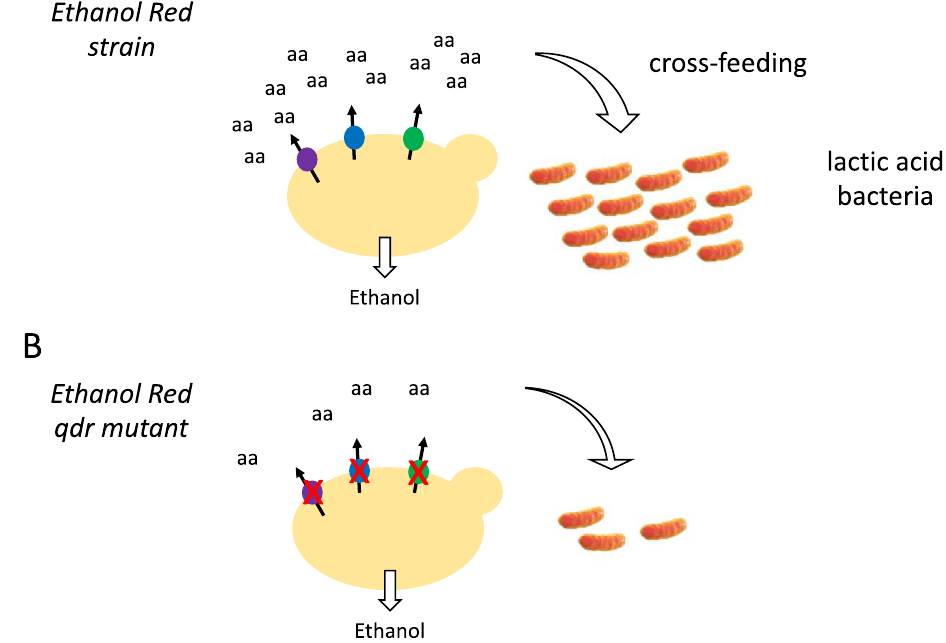
Figure 4. A novel strategy for reducing the risk of bacterial contaminations during bioethanol production. ( A ) The Ethanol strain used in this study excretes multiple amino acids via Qdr amino-acid exporters of the DHA1 family, thereby promoting proliferation of contaminating lactic acid bacteria. ( B ) Loss of Qdr transporters by means of homozygous mutations reduces amino acid excretion and cross-feeding of lactic acid bacteria, without altering ethanol